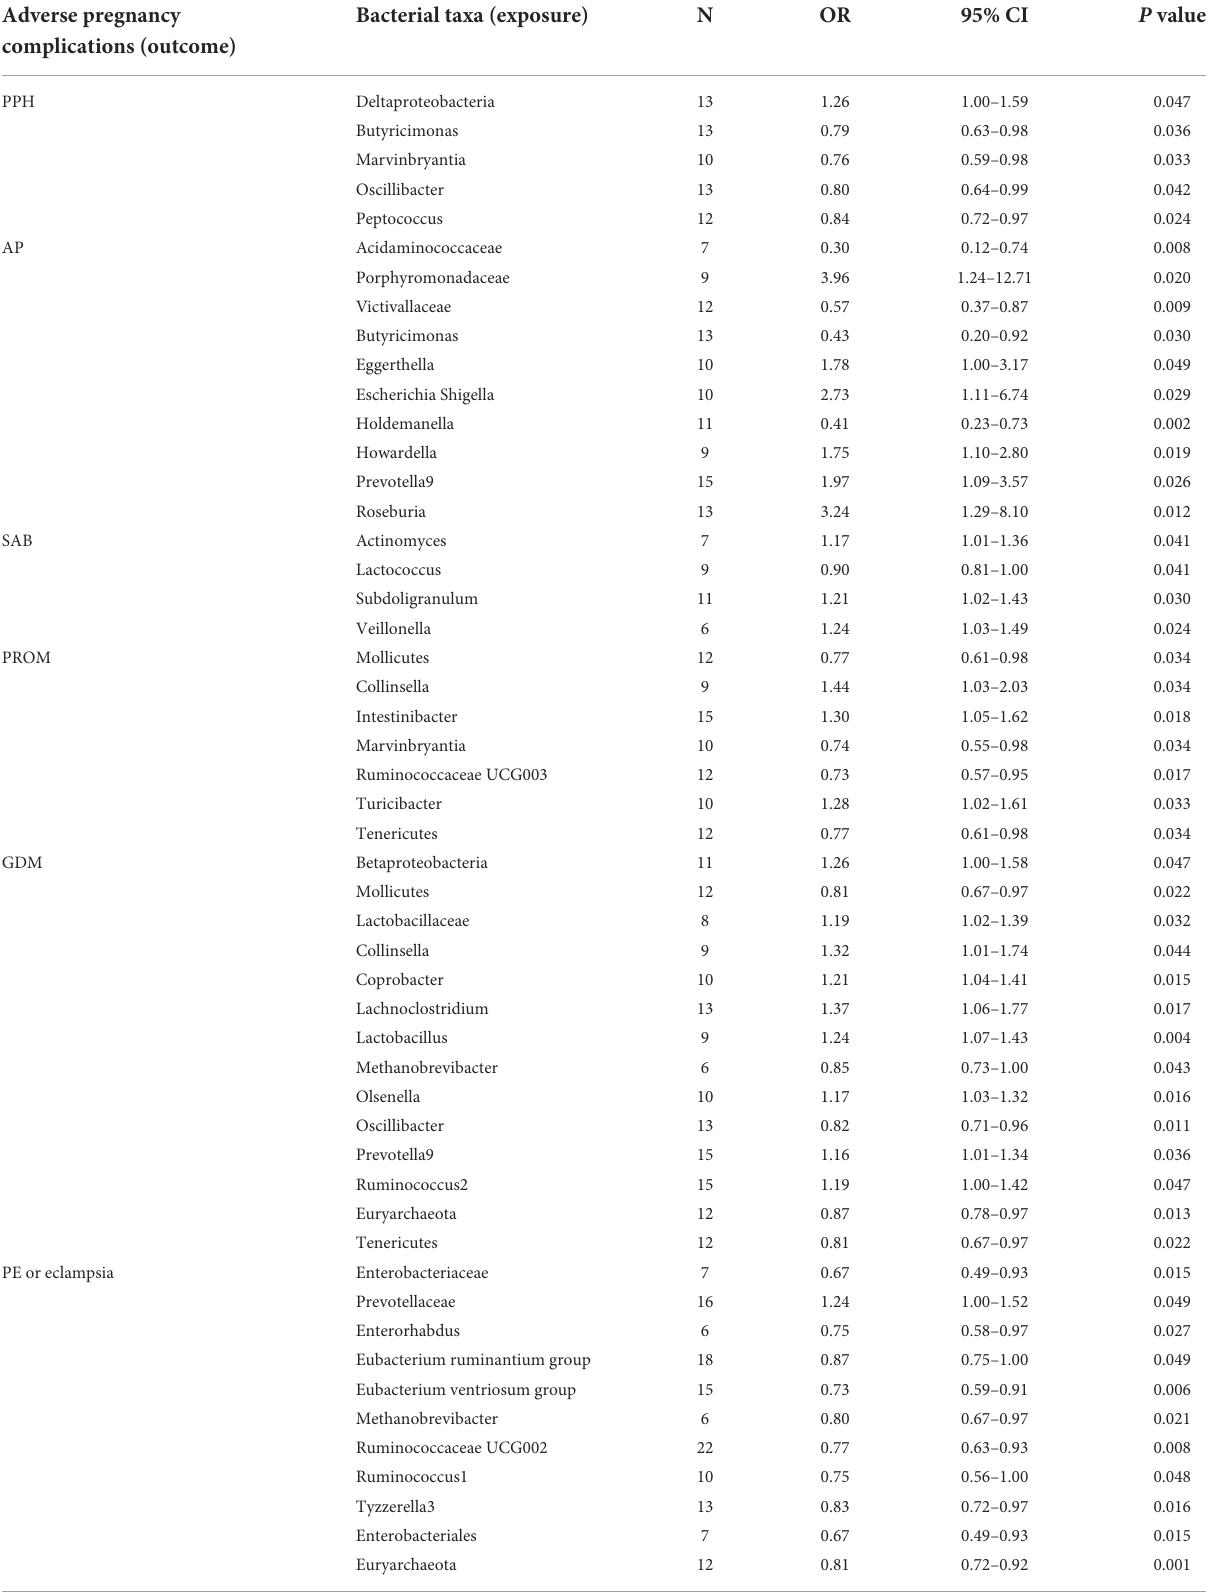
TABLE 1 Causal associations between gut microbiota and the risk of adverse pregnancy complications by using the IVW method. Adverse